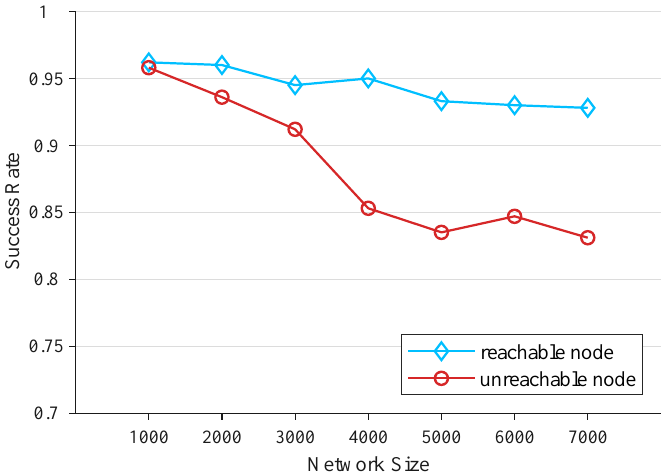
Figure 17. Lookup success rate of reachable and unreachable nodes at different network size.